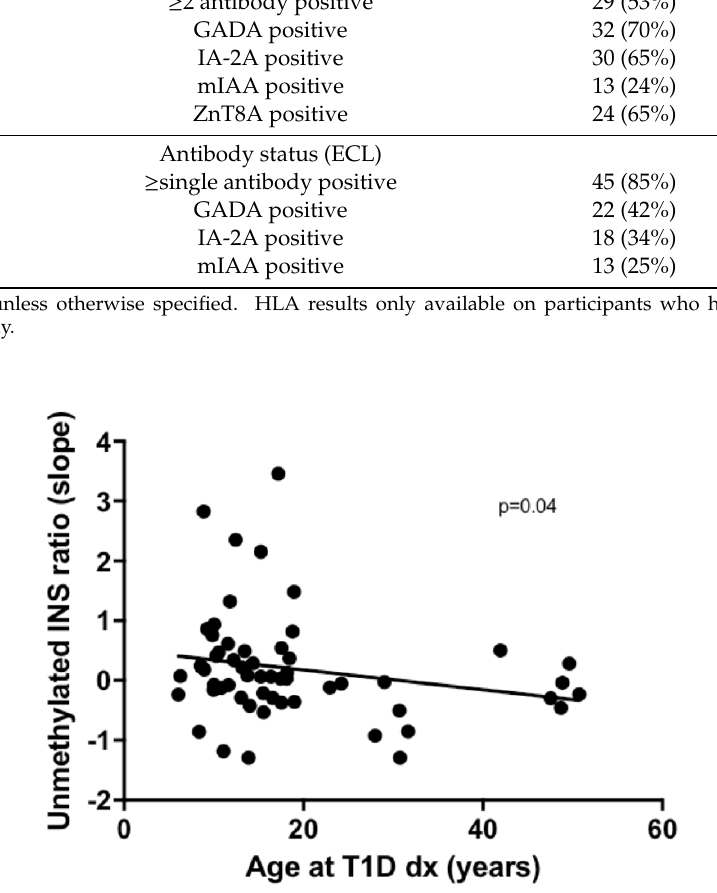
Figure 1. Association between the unmethylated INS ratio (ratio of unmethylated/methylated insulin DNA levels) and age at T1D Diagnosis. After adjusting for baseline unmethylated INS ratios,